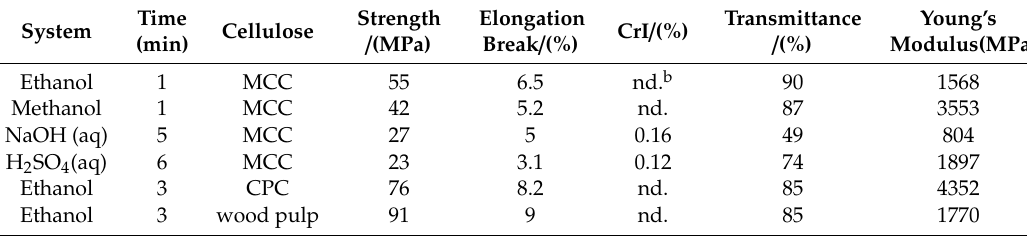
Figure 2. XRD patterns of raw cellulose powders and regenerated cellulose films. Table 1. Regeneration condition and physical properties of the cellulose films a